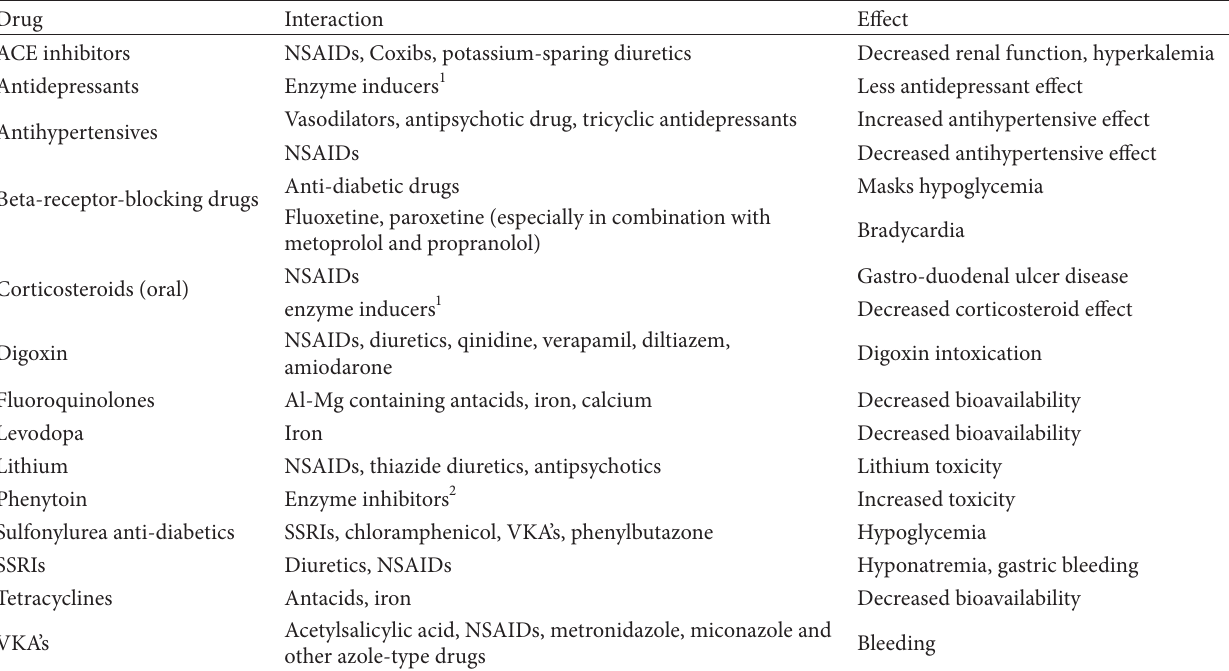
T 8: e most common drug interactions in elderly patients